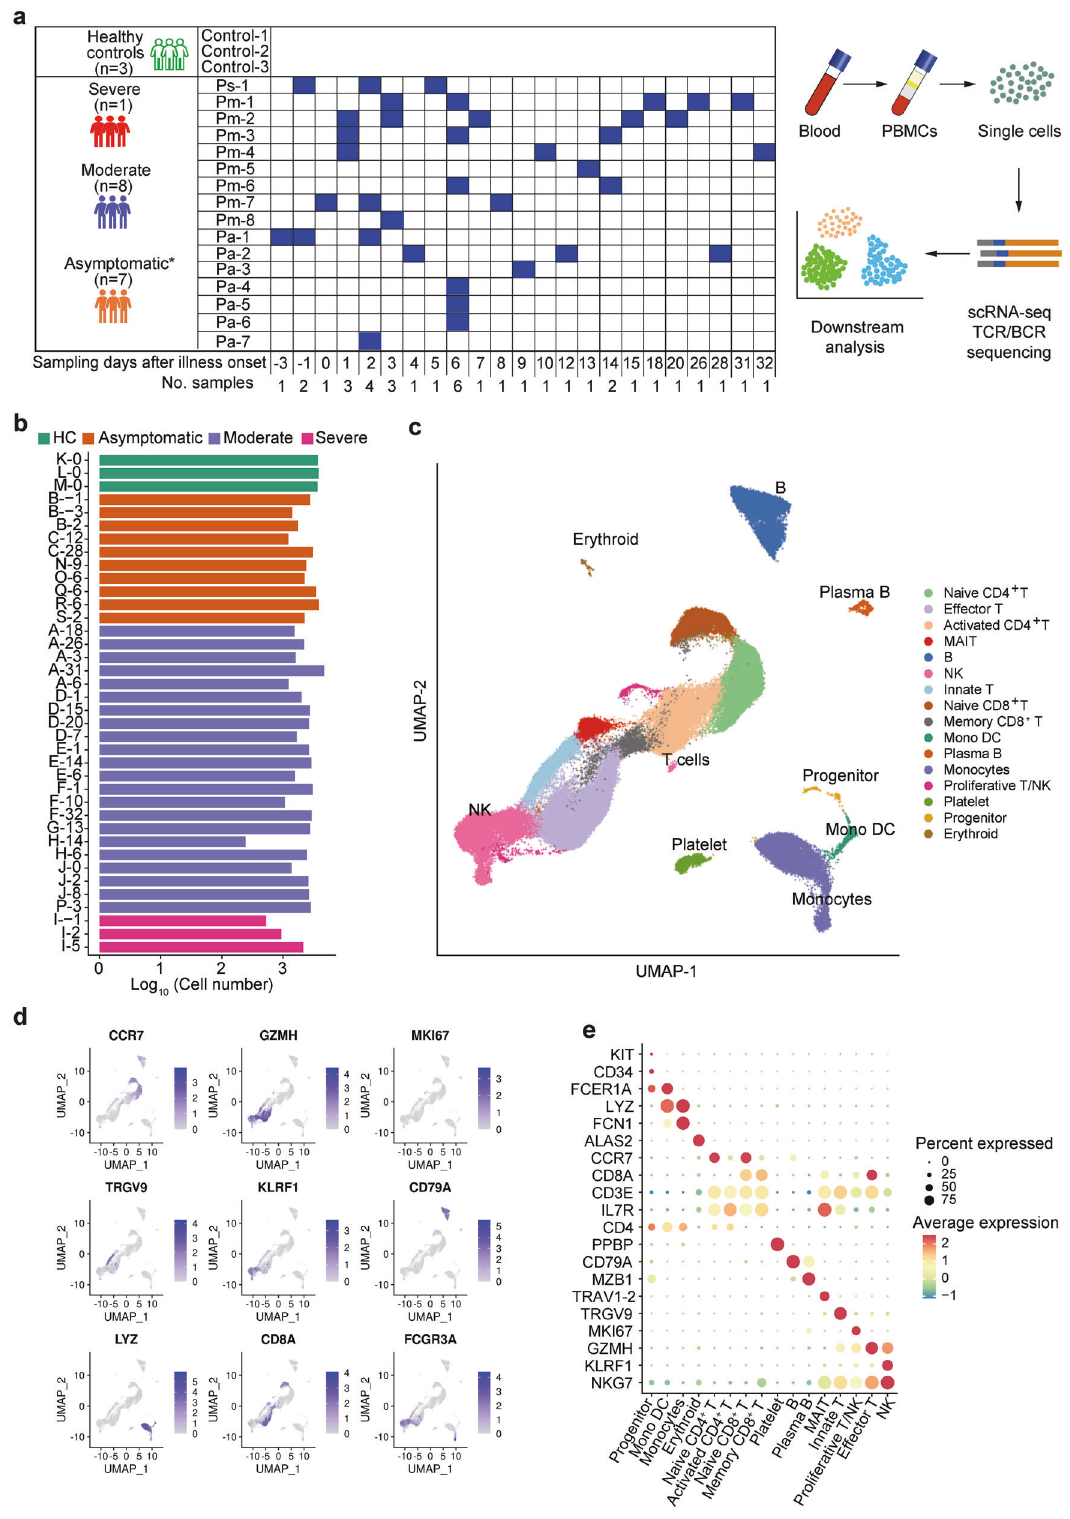
16 patients and 11,206 cells from three HCs. On average, there were 2300 cells for each PBMCs sample (Fig. 1b). We identi fi ed 16 major cell types (Fig. 1c – e; Supplementary Fig. 1a – c), including mucosal-associated invariant T (MAIT) cells ( IL17R + ), innate T cells ( TRGV9 + ), effector T cells ( GZMK + ), naive CD8 + T cells ( CCR7 +